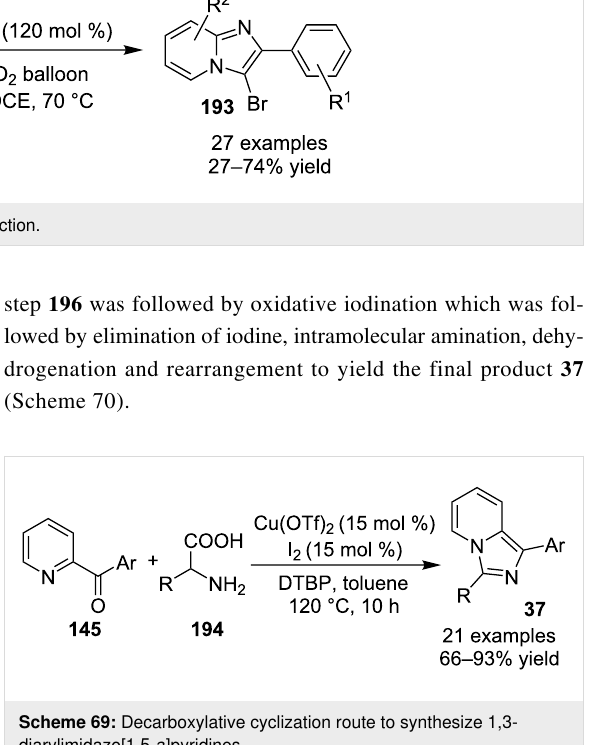
methyl- and meta -fluoro-substituted pyridines were obtained in an 1:1 isomeric mixture. Application of TEMPO (a radical tence of a radical intermediate in the mechanism. This radical